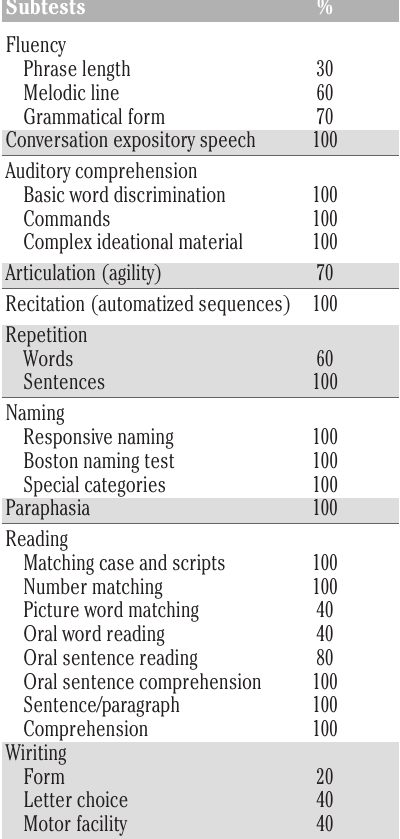
Table 1. Boston diagnostic aphasia test - version